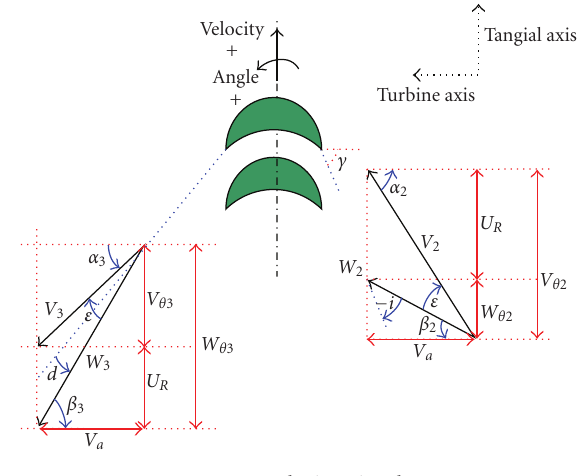
Figure 3: Velocity